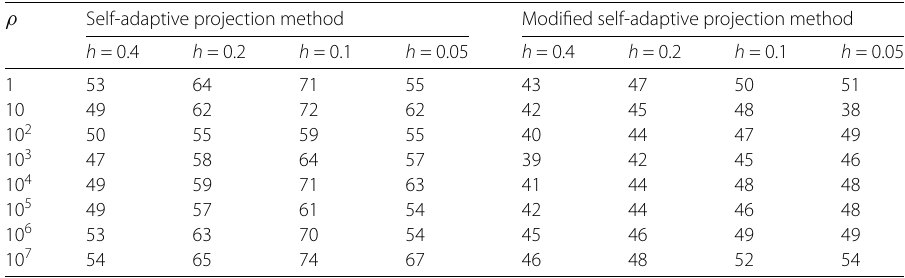
Table 2 Number of iterations for each method ρ Self-adaptive projection method Modified self-adaptive projection